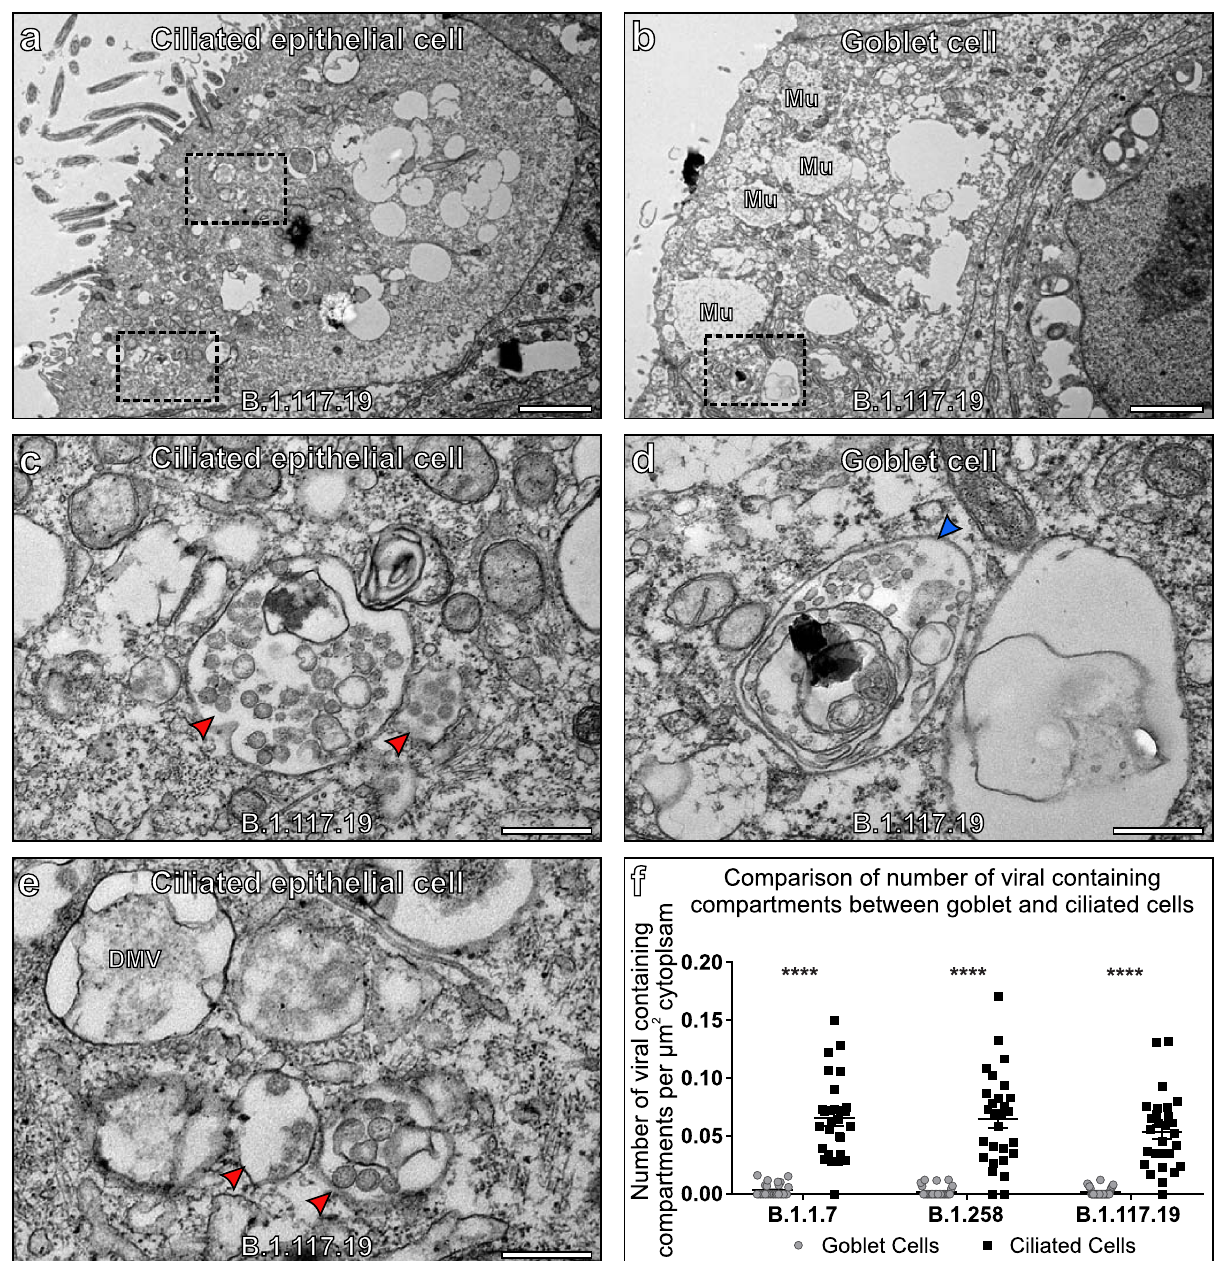
Fig. 4 Goblet cells show little evidence of SARS-CoV-2 infection. a – c Ciliated cells contain readily identi fi able viral-containing compartments (red arrowhead) and double-membrane vesicles (DMV). d , e Goblet cells contain endosomes and endolysosomes (blue arrowhead) that have a similar appearance to viral-containing compartments but can be differentiated by the lack of viral nucleocapsid protein and S glycoprotein structures. Goblet cells also contain mucin-containing secretory granules (Mu). f Very few VCs were found in goblet cells for all three isolates. Single sample for each examined and the number of cells assessed N = 28. Mean and SEM are shown, and statistical signi fi cance was determine using paired, two-tailed Student ’ s t